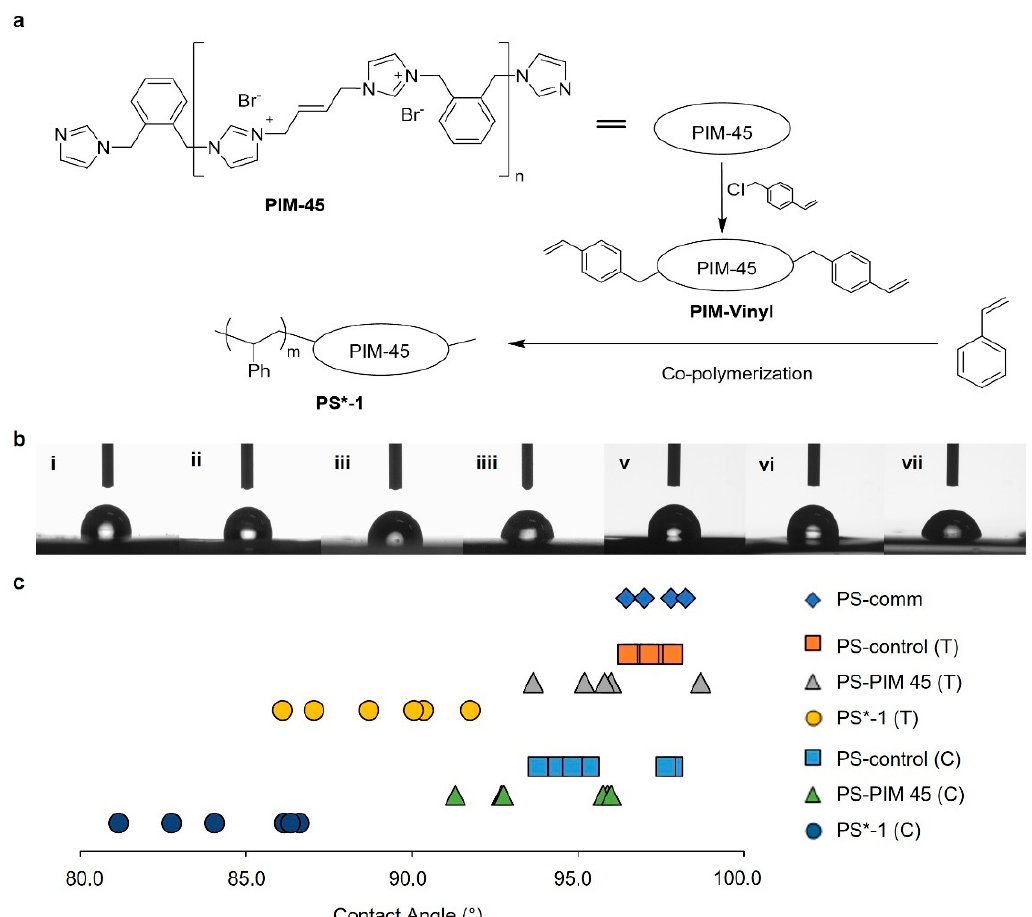
Figure 1. Synthesis and surface wettability of PS*-1. ( a ) Synthetic scheme for the modified polyimidazolium material (PIM-Vinyl) and functionalized polystyrene (PS*-1 with 1 wt.% of PIM-Vinyl). ( b ) Static water contact angle of (i) commercially available PS (PS-comm), (ii) PS-control (toluene), (iii) PS-PIM 45 (toluene), (iv) PS*-1 (toluene), (v) PS-control (chloroform), (vi) PS-PIM 45 (chloroform), (vii) PS*-1 (chloroform). ( c ) Average contact angle distribution of different PS film